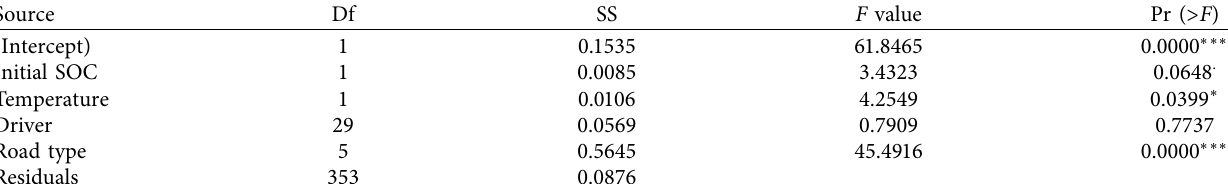
Figure 2: Jitter plot of mean energy consumptions for all road types. Table 6: ANOVA of the road type